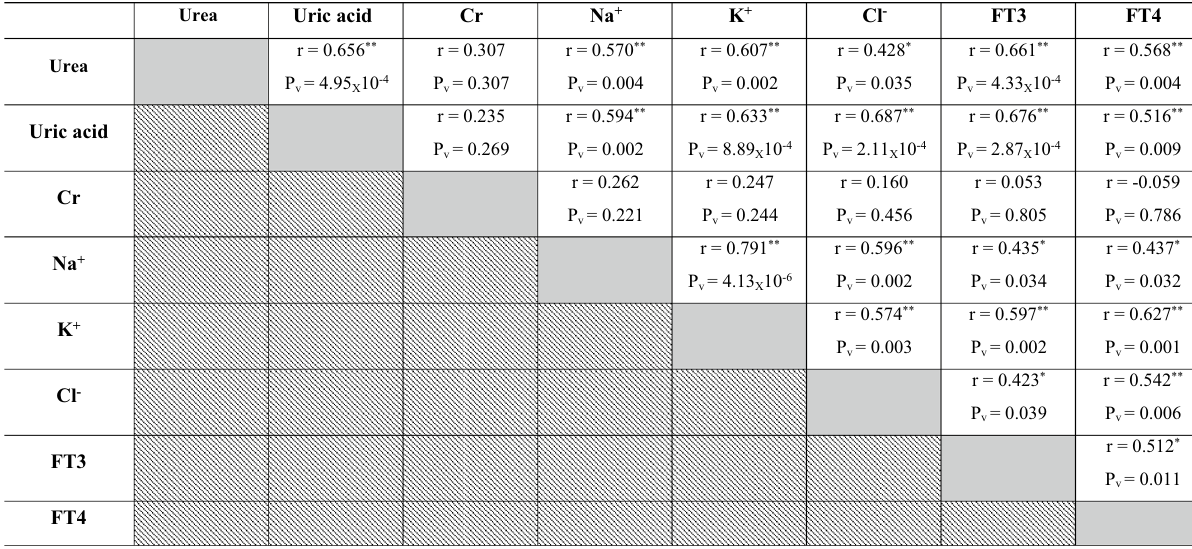
Table 5. Pearson correlation coefficient between renal indicators, serum electrolytes and thyroid function parameters in investigated Dabb lizards. Cr Creatinine, Na + Sodium, K + Potassium; Cl − Chloride, FT3